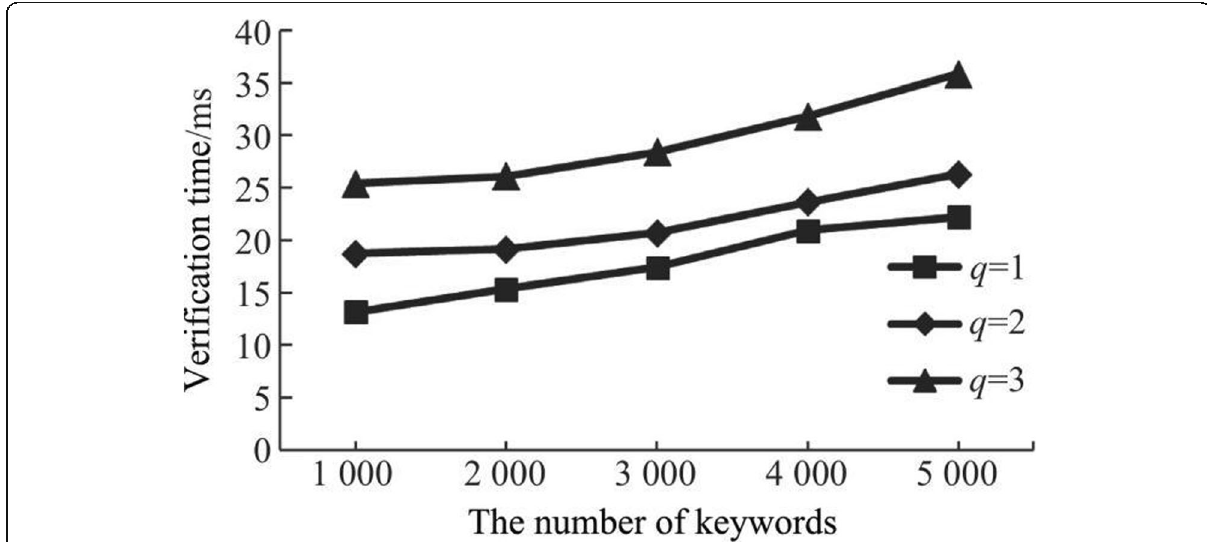
Fig. 16 Time of verifying. shows the change curve between the verification time and the number of keywords when the number of query words is 1. shows the change curve between the verification time and the number of keywords when the number of query words is 2. shows the change curve between the verification time and the number of keywords when the number of query words is